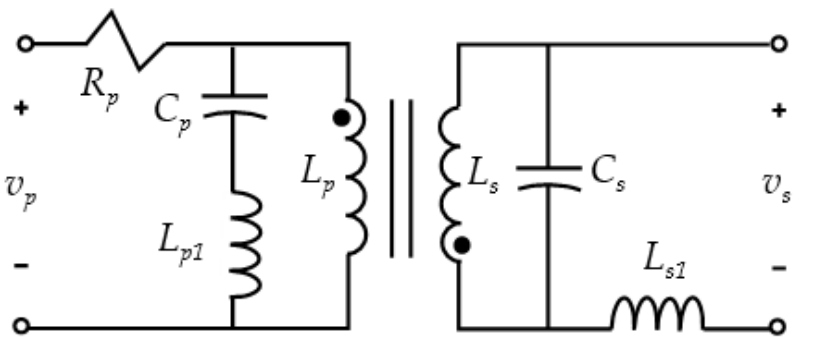
Figure 8. SPICE Simulation.